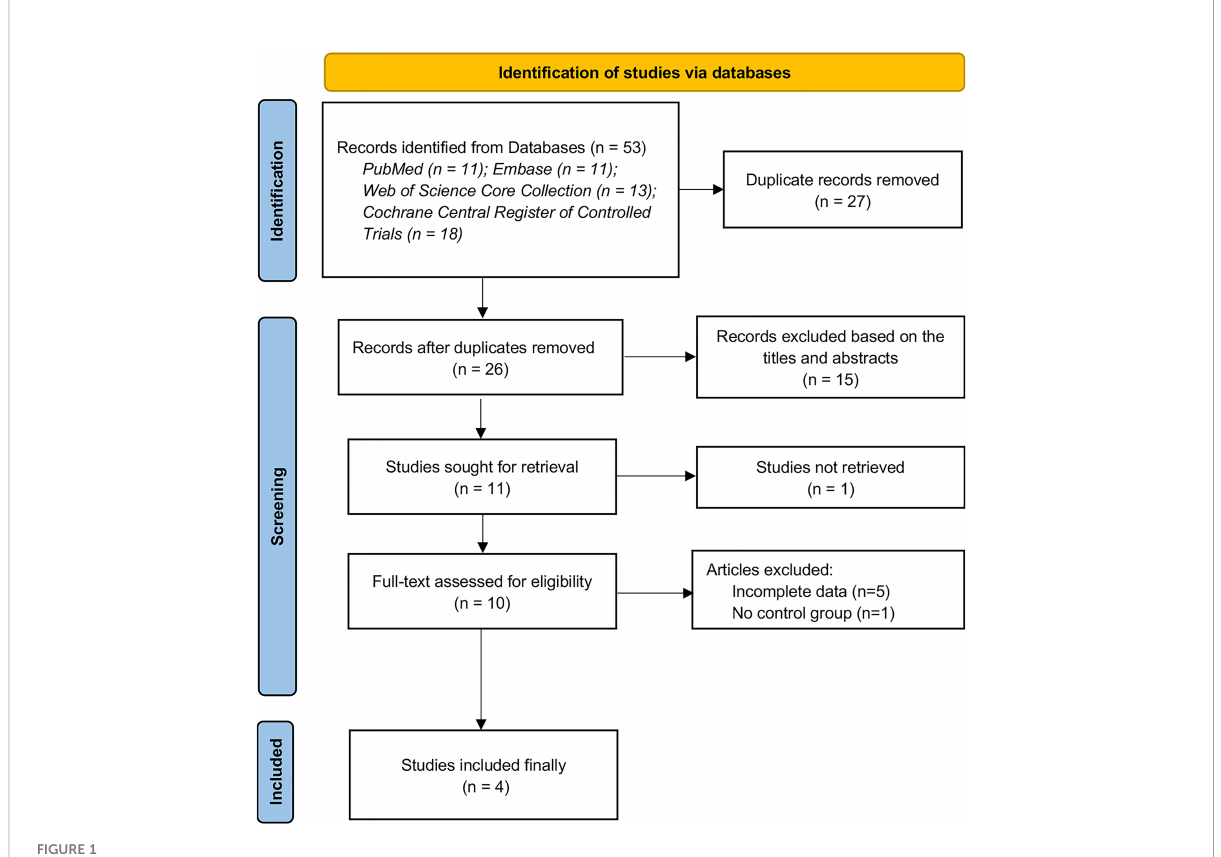
FIGURE 1 Flow chart of study